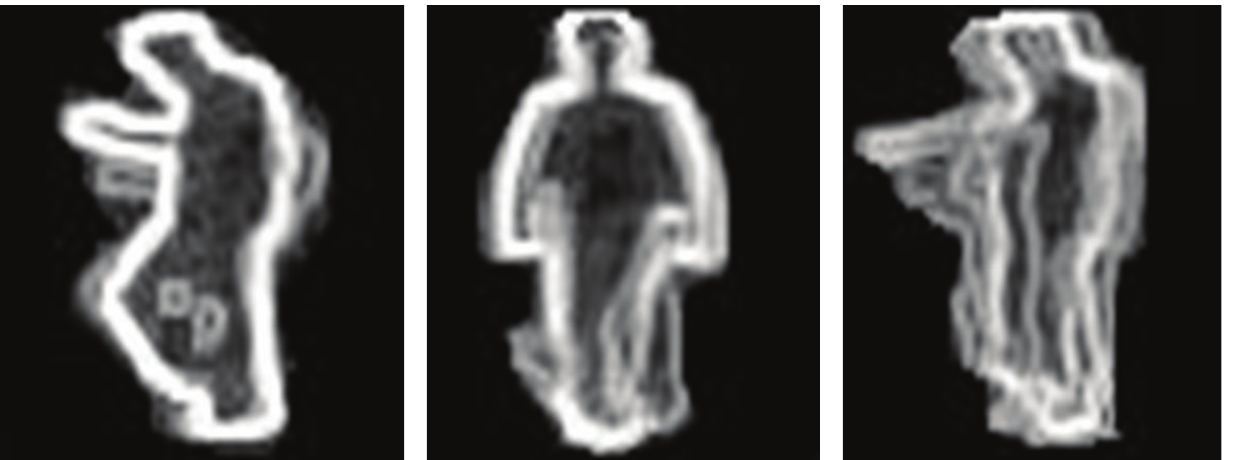
Figure 6: Depth motion identification features applied over exercise, kicking, and cleaning activities.